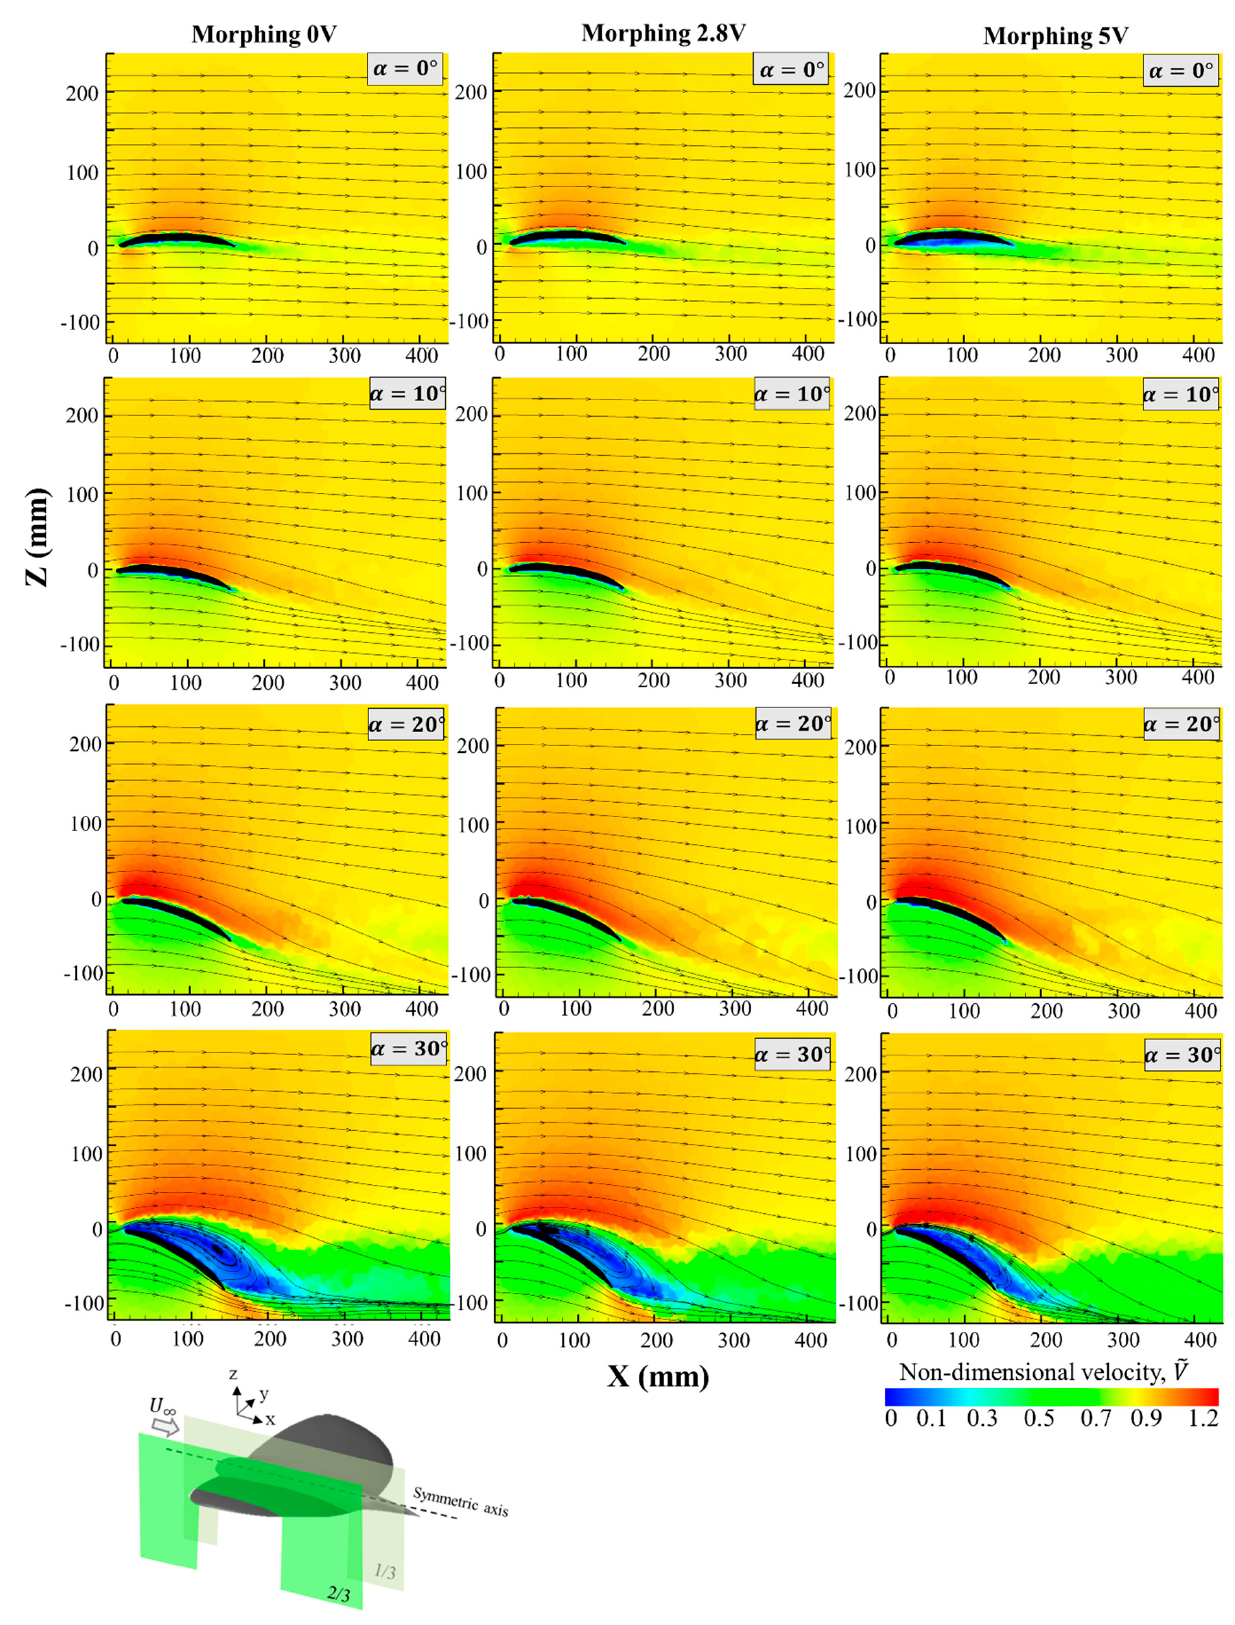
Figure 8. Non-dimensional velocity maps at 2/3 (cid:101) b for all wing configurations: morphing 0 V, 2.8 V and 5 V ( U ∞ = 10 m/s, β = 0 ◦ ).